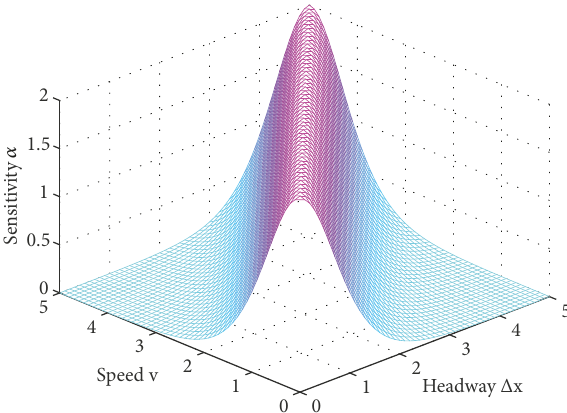
Figure 1: Phase diagram in the headway-speed-sensitivity space (v max =2.0